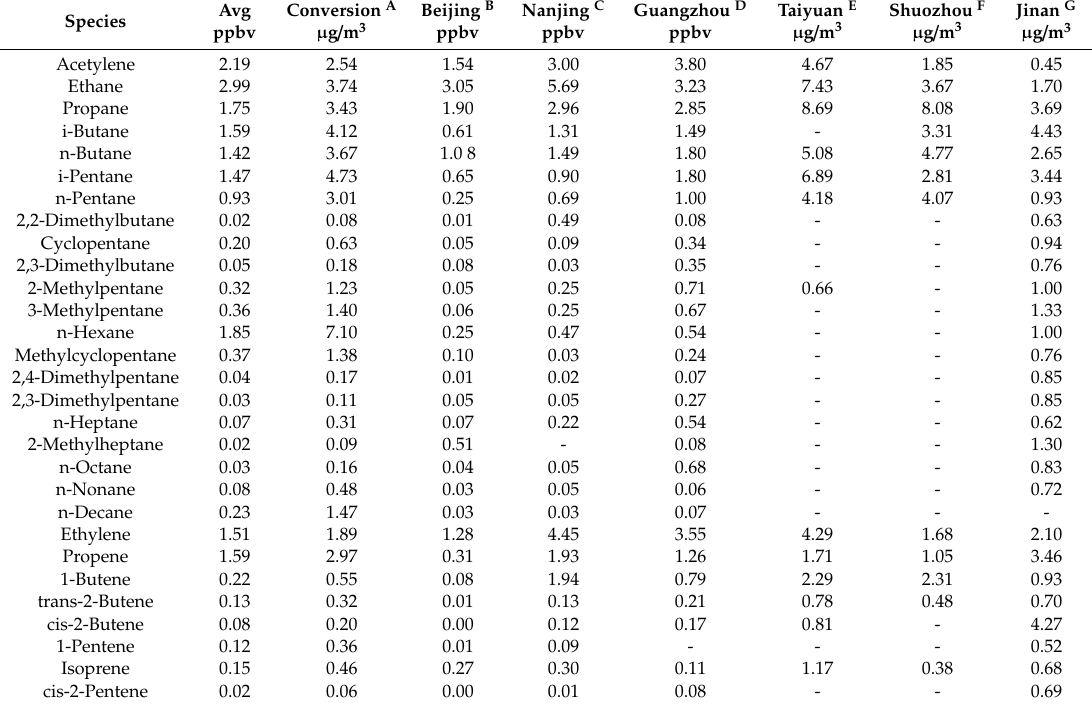
Table 1. Observed VOC concentrations compared among major cities in